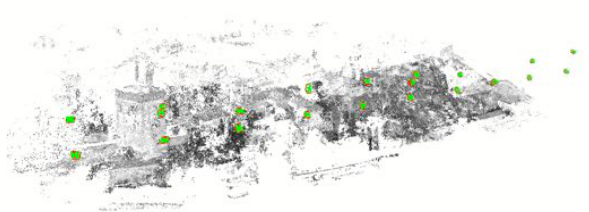
Figure 5. Sift point cloud and aerial image orientation of Tour Philippe le Bel surroundings, with Apero